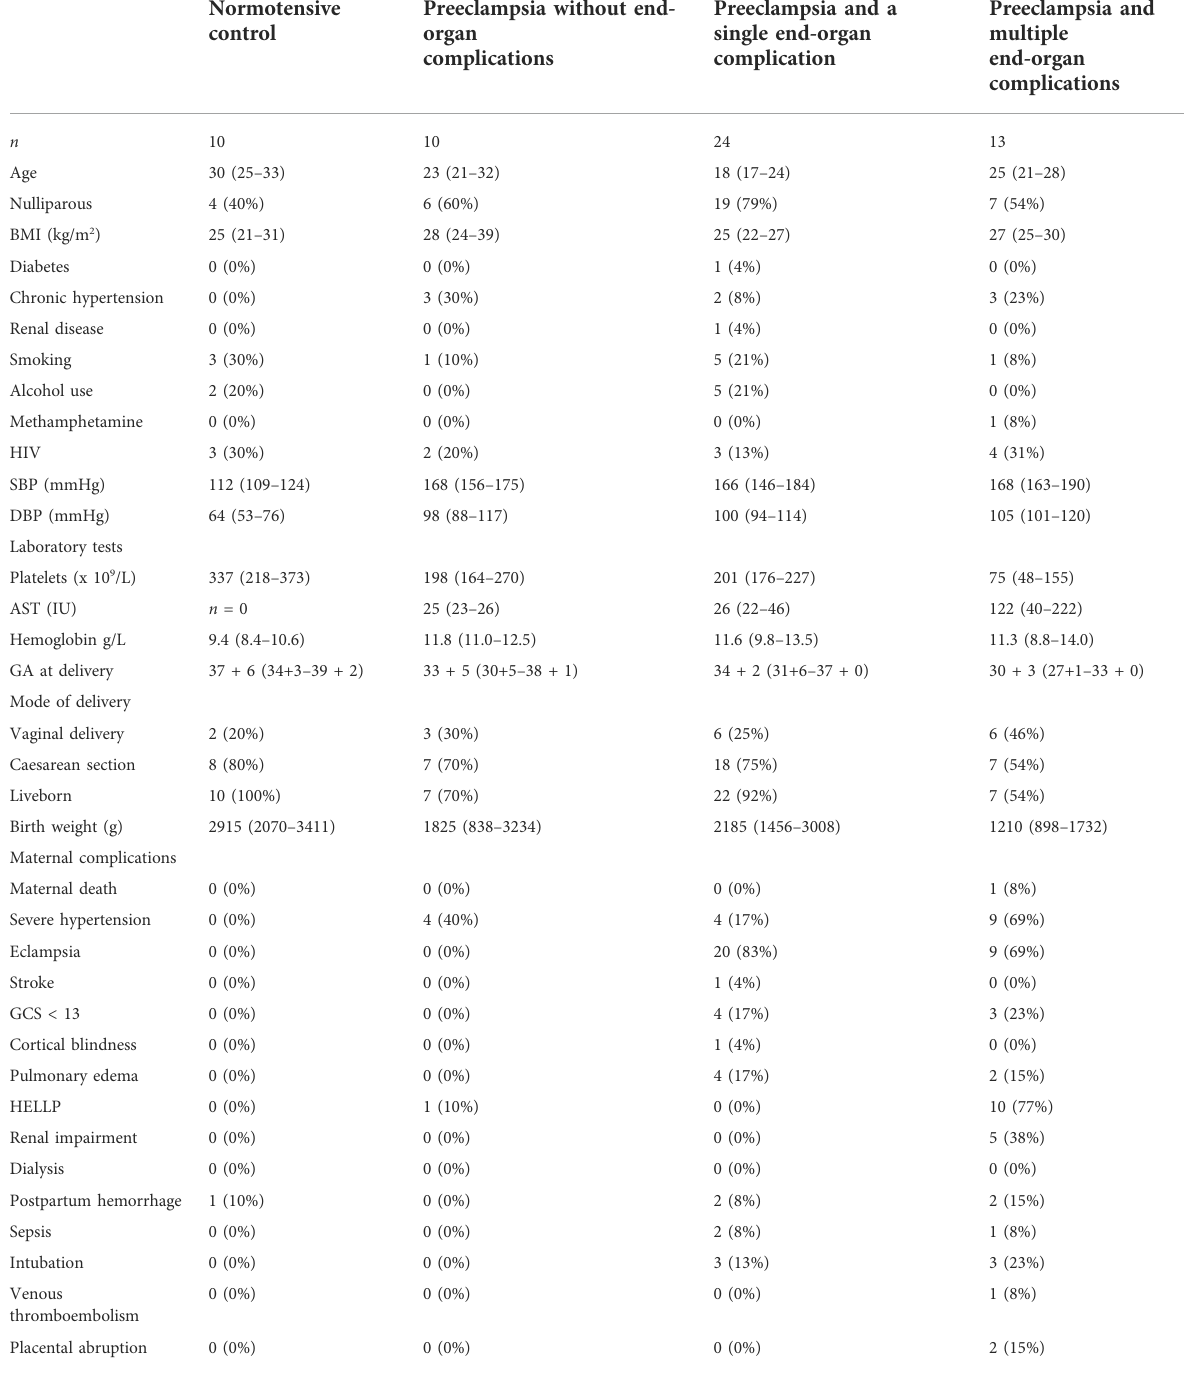
TABLE 1 Background characteristics of the